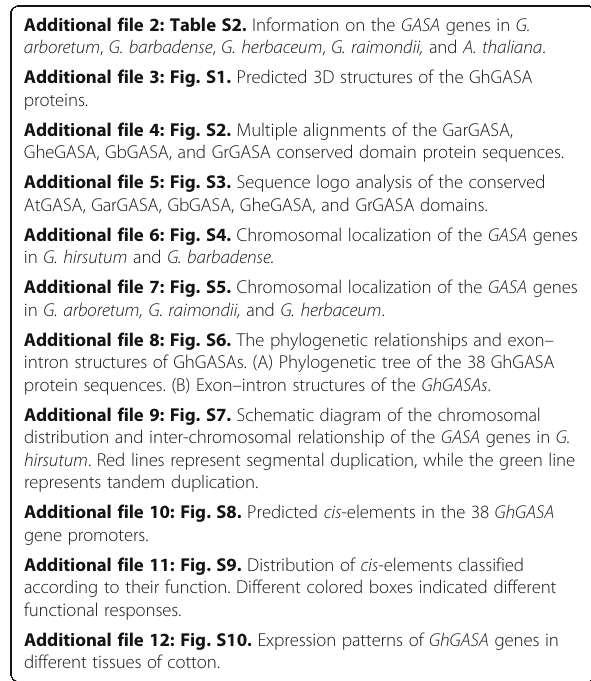
Additional file 9: Fig. S7. Schematic diagram of the chromosomal distribution and inter-chromosomal relationship of the GASA genes in G. hirsutum . Red lines represent segmental duplication, while the green line represents tandem duplication. Additional file 10: Fig. S8. Predicted cis -elements in the 38 GhGASA gene promoters. Additional file 11: Fig. S9. Distribution of cis -elements classified according to their function. Different colored boxes indicated different functional